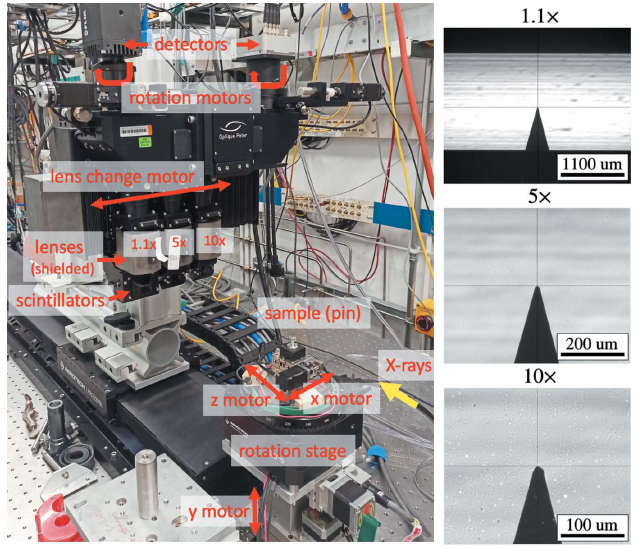
Figure 2 The Optique Peter microscope system at beamline 2-BM of the Advanced Photon Source (left). Result of automatic sample alignment for different magnification with x , z motors on the rotation stage, vertical y motor under the stage, and detector rotation motors on the top of the Optique Peter system (right).